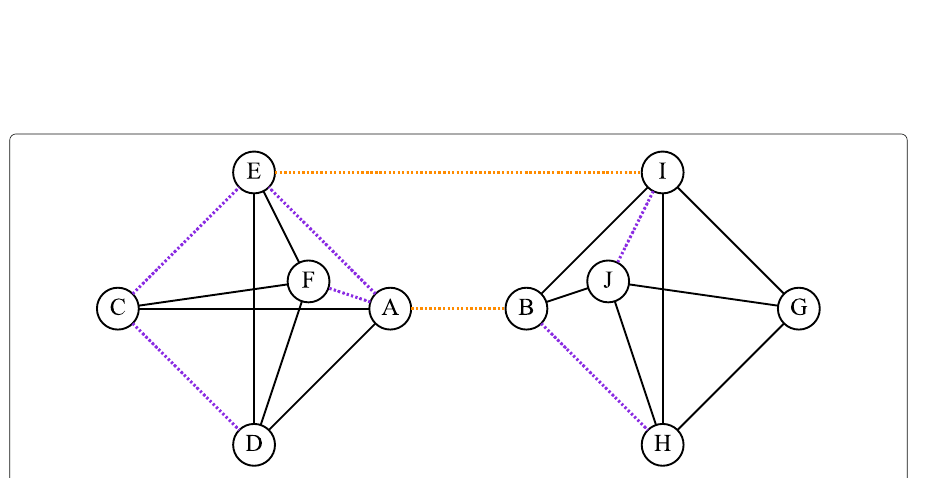
Fig. 7 Granovetter’s 1973 Example A